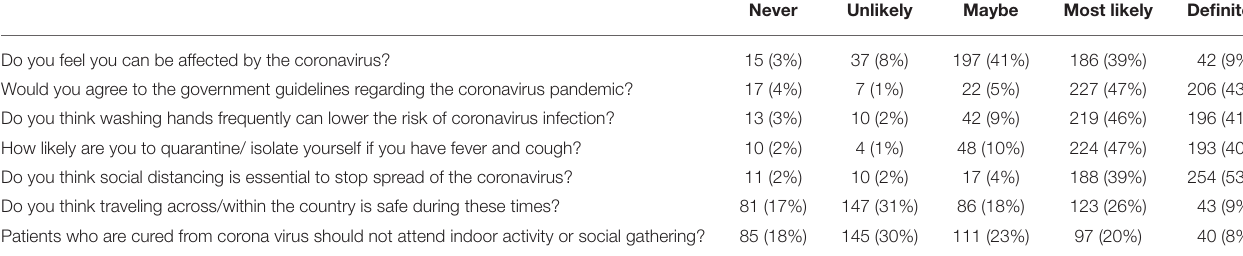
TABLE 5 | Attitude toward COVID-19